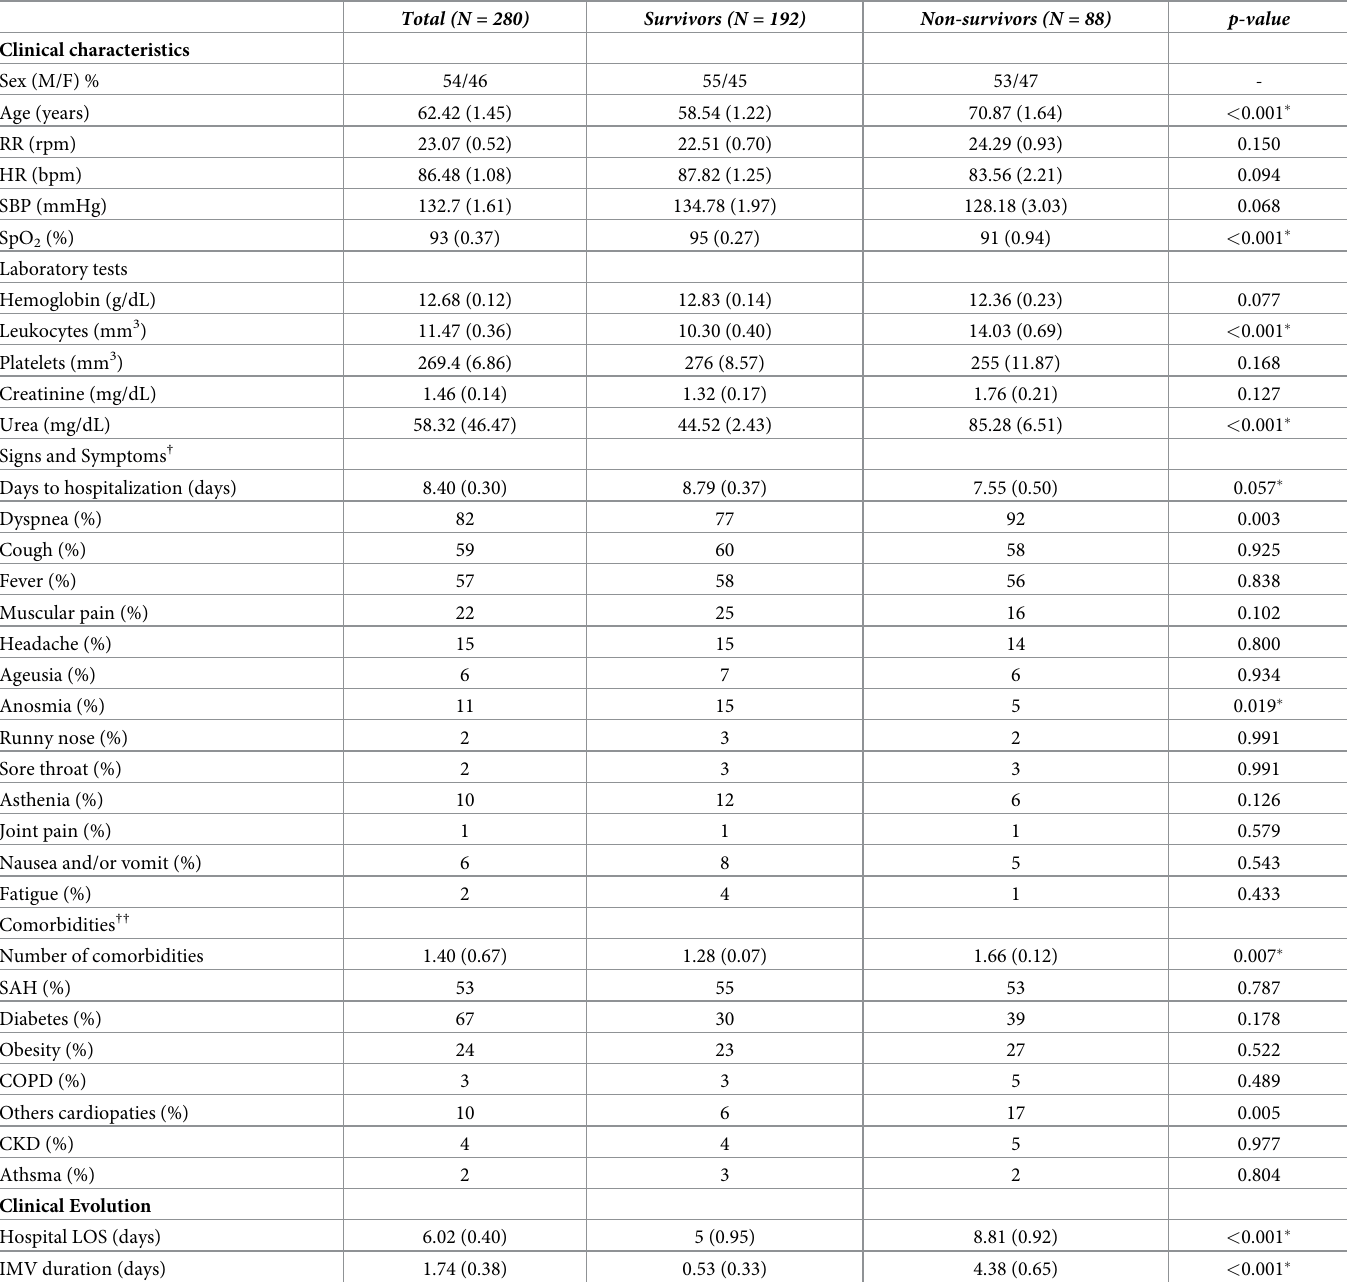
Table 1. Clinical characteristics, laboratory tests, signs and symptoms, and